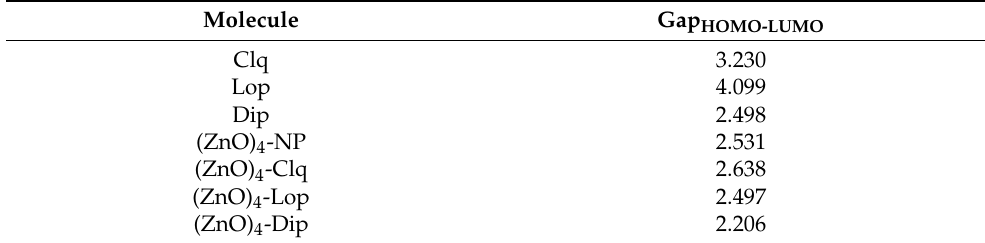
Table 2. Gap energies for the studied molecules, in eV.